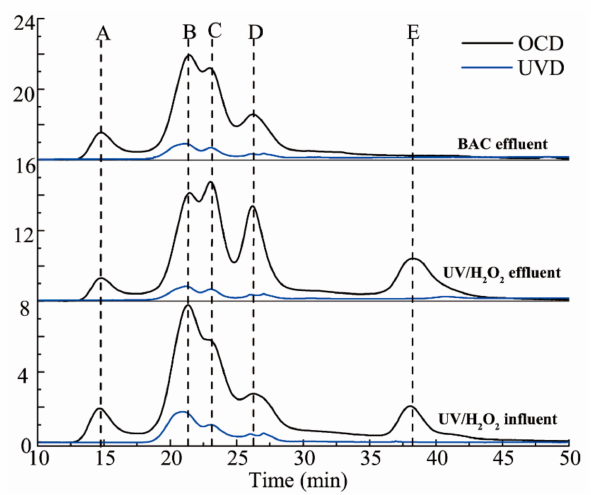
Figure 5. Variation tendency of organic carbon detection (OCD) and UVD signals. Table 3. Results of liquid chromatography-organic carbon detection (LC-OCD) fractionation. Humic